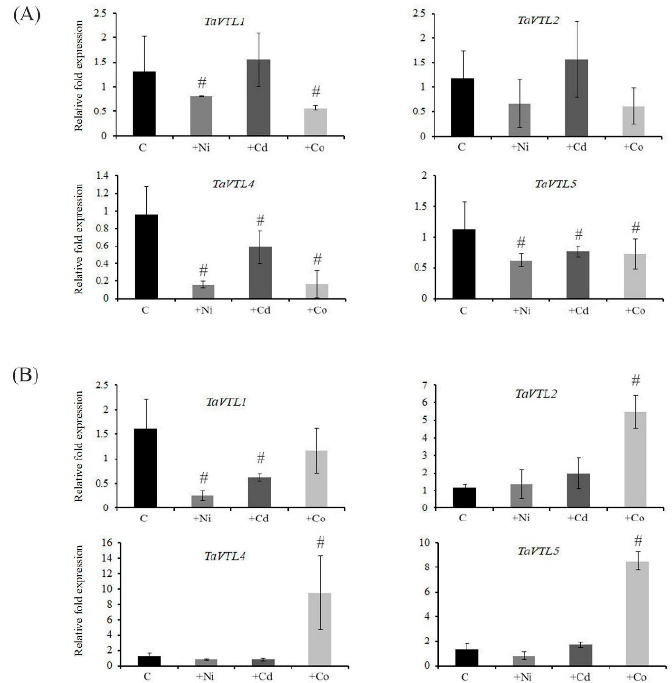
Figure 7. Tissue-specific qRT-PCR expression analysis of wheat VTL genes upon heavy metal treatments. Wheat seedlings were exposed to Ni ( + Ni, 50 µ m), Cd ( + Cd, 50 µ m) and Co ( + Co, 50 µ m). Control seedlings (C) without any exposure to heavy metals were compared with the treated ones. ( A ) Fold expression analysis was performed in roots and ( B ) in shoots. 2 µ g of total RNA for the cDNA preparation and relative fold expression levels were calculated relative to control samples. C t values were normalized using wheat ARF1 as an internal control. Vertical bars represent the standard deviation. # represents the significant difference at p < 0.05 with respect to their respective control treatments.